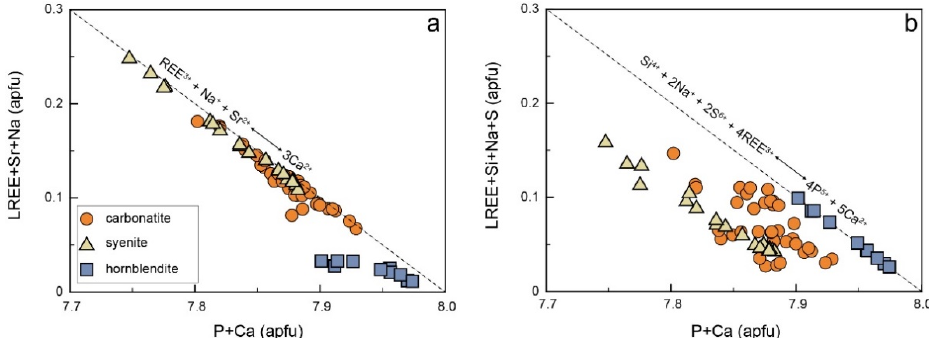
Figure 6. Elemental substitution mechanisms for apatites in SXD complex. Correlations of (Ca + P) with ( a ) (LREE + Sr + Na) and ( b ) (LREE + Si + Na + S).